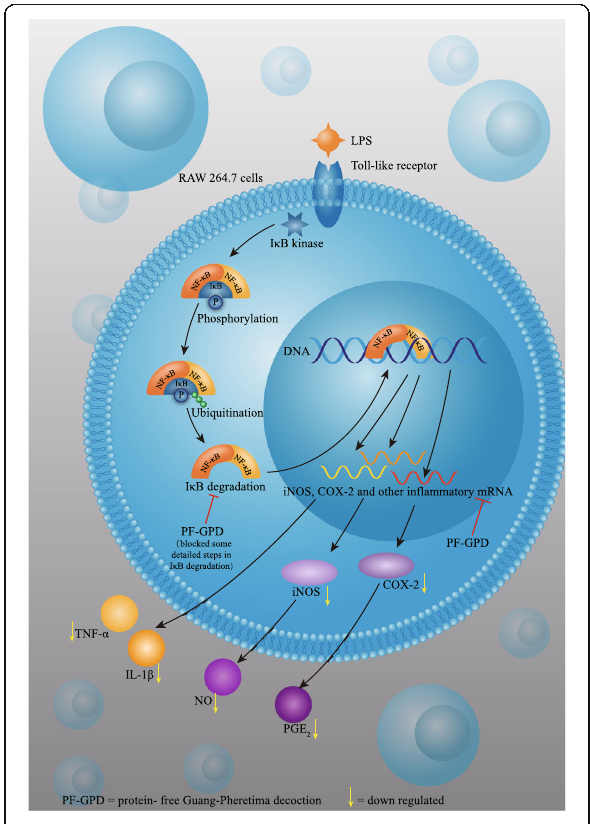
Fig. 8 The mechanism of anti-inflammatory activities of PF-GPD in LPS-stimulated RAW 264.7 murine macrophage